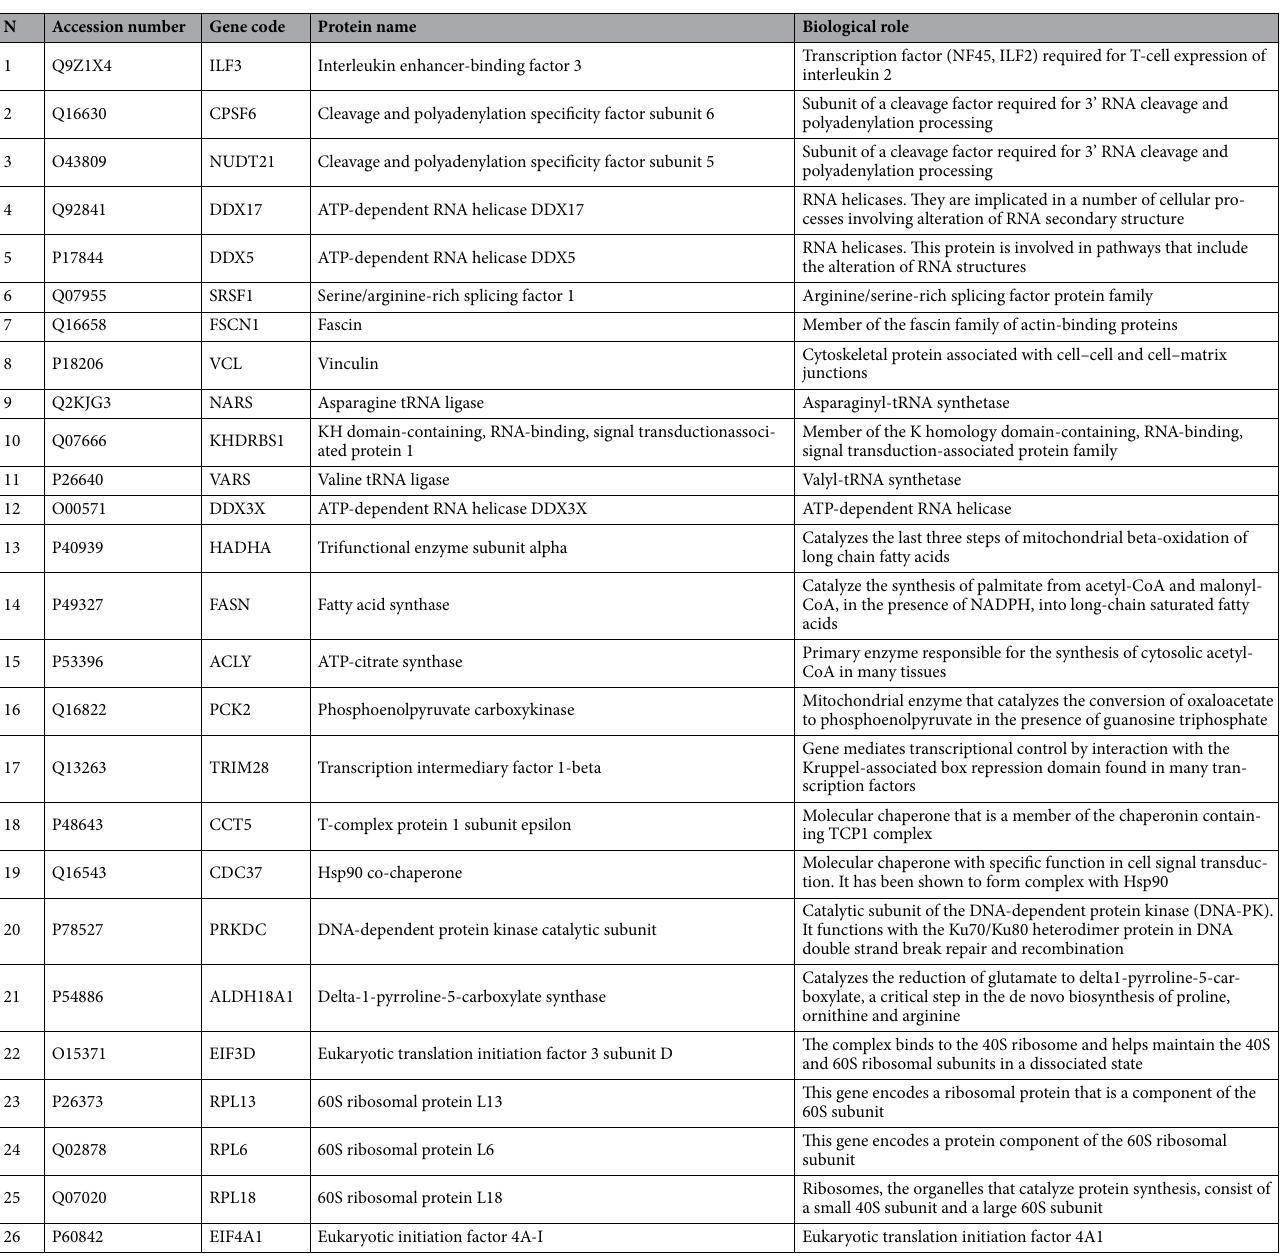
Table 1. List of identified proteins in Hakai interactome